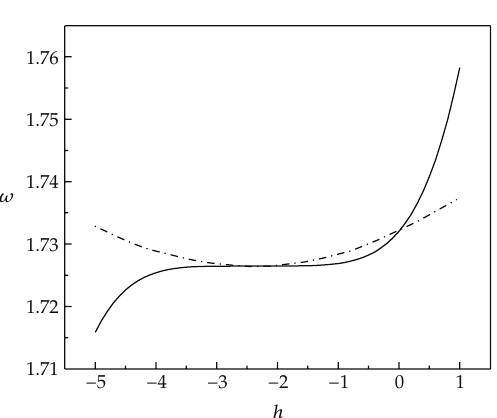
Figure 1: The h -curves for the frequency ω . Dash-dotted curve: 2nd-order approximation; solid line: 5th- order approximation (cid:3) ξ (cid:9) 1 . 063, α (cid:9) 1, θ (cid:9) 0 . 999939 (cid:4) .